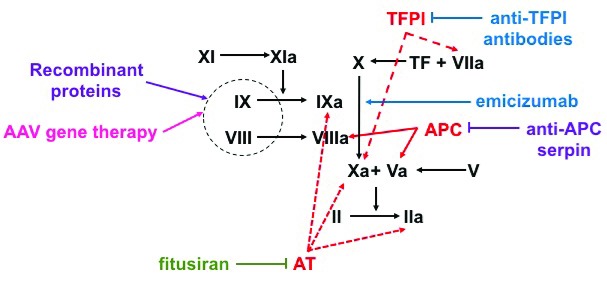
Mechanism of action of hemophilia therapies.Factor X (FX) can be activated to FXa either via FIXa–FVIIIa complex or the tissue factor (TF) factor–FVIIa complex. FXa and FVa activate prothrombin (FII) to thrombin (FIIa) in order to generate a fibrin clot. Natural anti-coagulants targeted by non-factor therapeutics are represented in red. Protein-based therapeutics are represented in purple, nucleotide-based therapeutics are represented in blue, and antibody-based therapeutics are represented in green. Fitusiran decreases the production of antithrombin (AT), decreasing its inhibition of FIXa, FXa, and FIIa. Concizumab and anti-protein C serine protease inhibitors (serpins) block tissue factor pathway inhibitor (TFPI) from inhibiting FXa and TF–FVIIa complex or protein C from inhibiting FVIIIa and FVa, respectively. Emicizumab is a FVIIa mimic that brings together FIXa and FX to generate FXa. Factor-based therapies include adeno-associated virus (AAV)-based liver-directed gene therapy, which results in endogenous factor production, and exogenously given factor therapeutics given intravenously. APC, activated protein C; EHL, extended half-life.